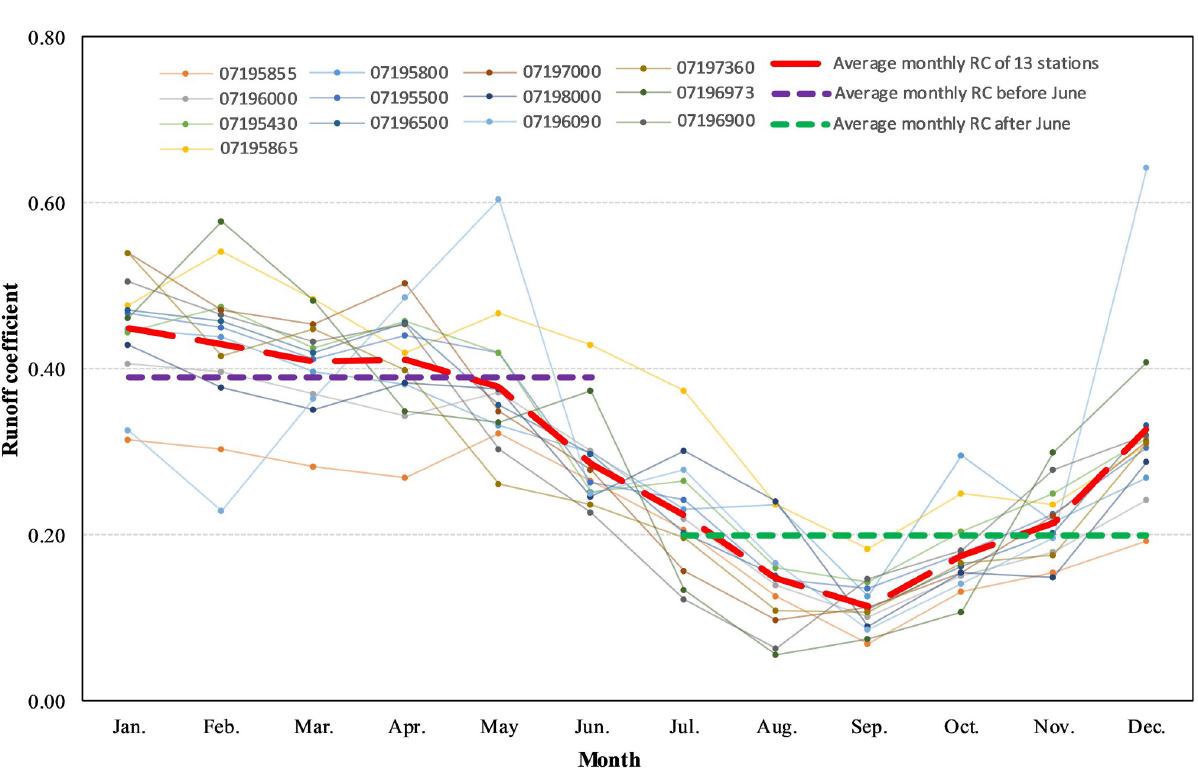
Fig 3. Average monthly runoff coefficient on 13 subwatersheds in the IRW.